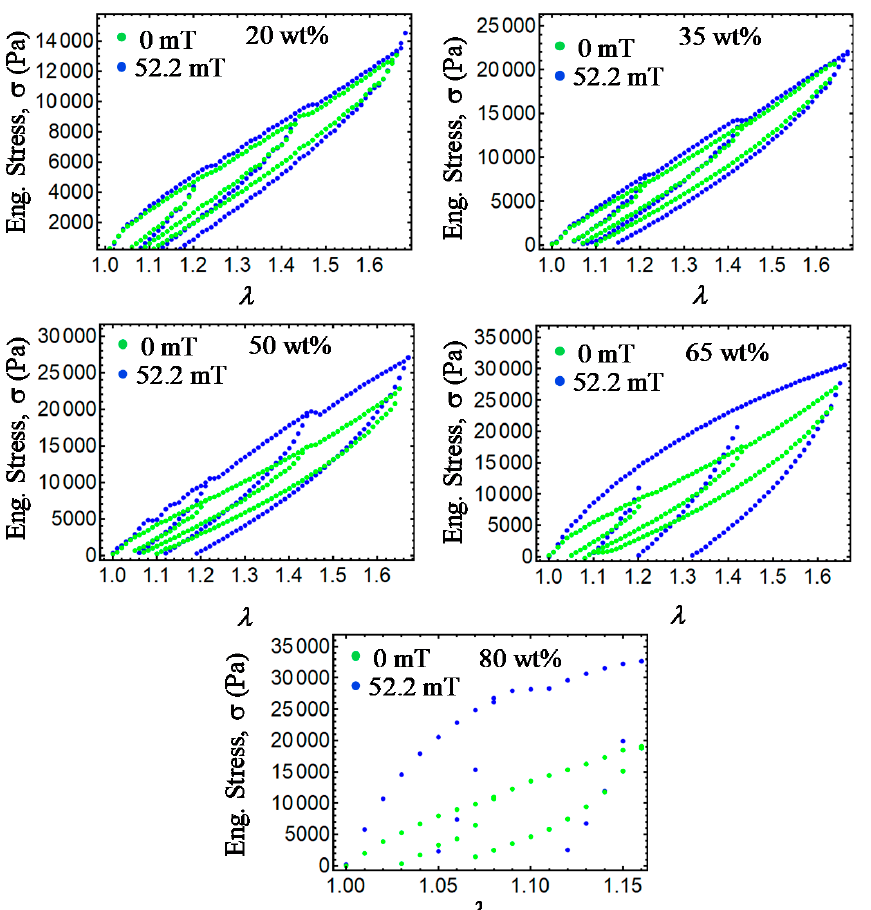
Figure 19. Collected experimental data for isotropic magnetorheological material samples subjected to loading and unloading cycles with and without the action of a magnetic flux density. Notice that for increasing wt% of CIPs, the material shear moduli, the engineering stress, the dissipation of energy, and residual strains tend to increase.